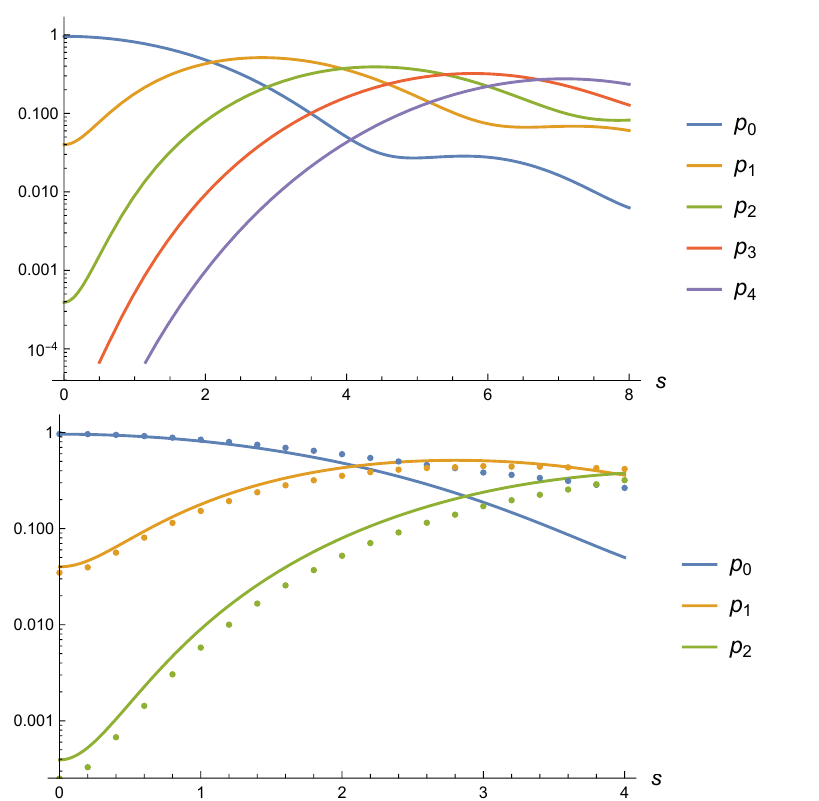
Figure 23 . (Top) Sketch of the ( χ -leading) modular flowed sector probability p k as a function of modular parameter s . One can see the shift of dominance to higher k sectors as s increases. (Bottom) The numerical result of p for k = 0 , 1 , 2 , shown as colored dots. The bond dimensions k used in the numerics are { χ = { 16 , 16 , 40 , 40 , 4 } . One sees a good match with A , χ B , χ C 1 , χ C 2 , χ } the analytical prediction at small s . To match the behavior at larger s one would need to access higher k sectors in the